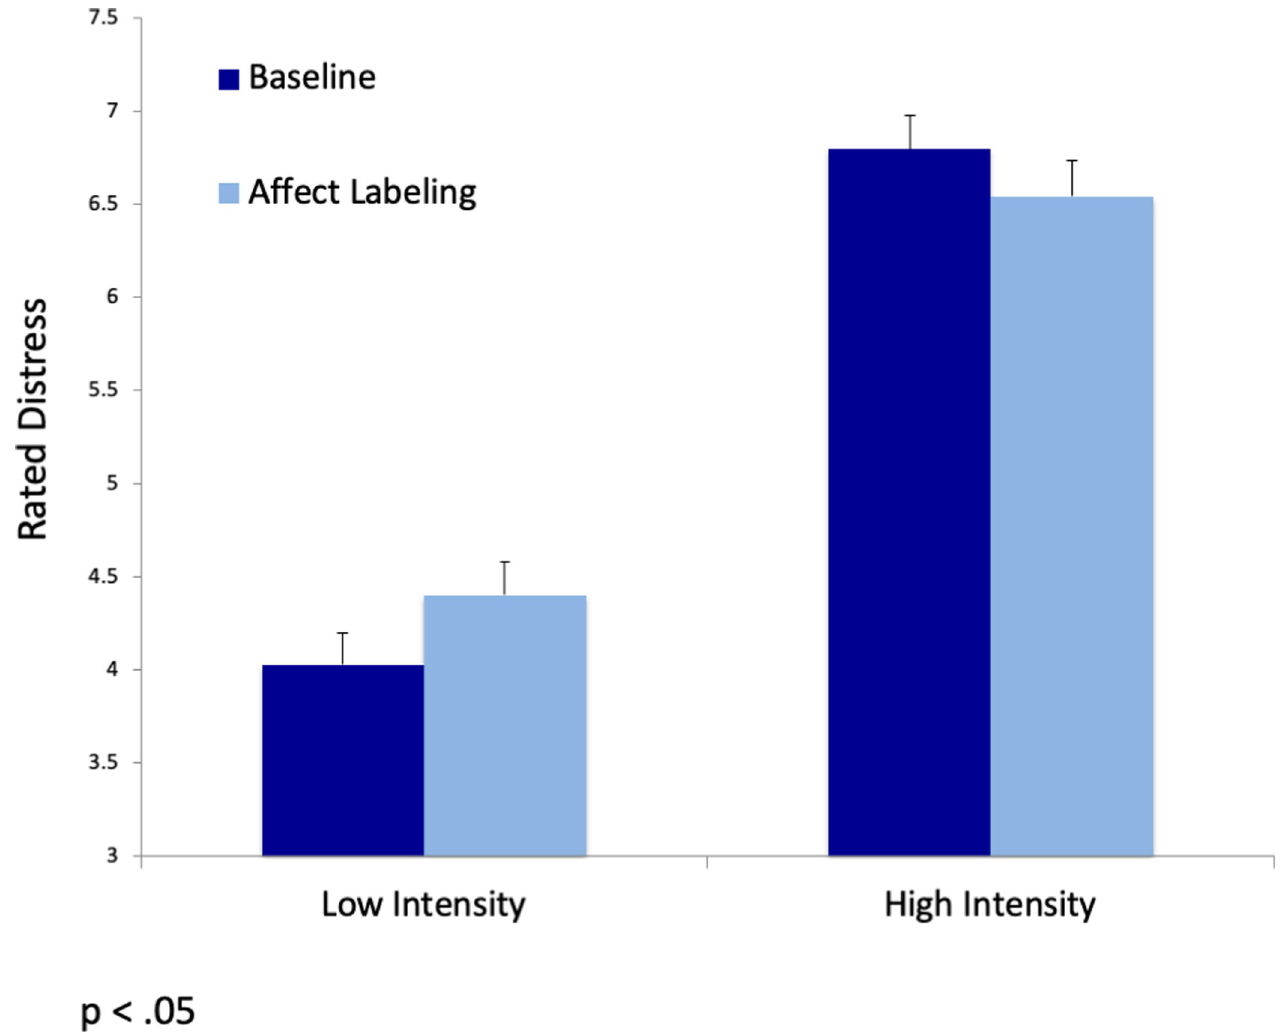
Fig 2. Level of distress (means and SE) as a function of regulation type (baseline/affect labeling) and intensity (low/high).